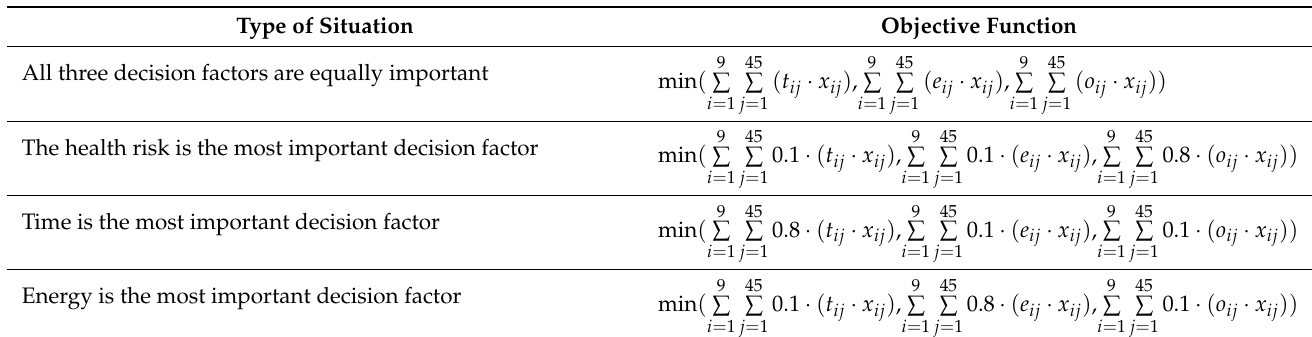
Table 4. Differently weighted